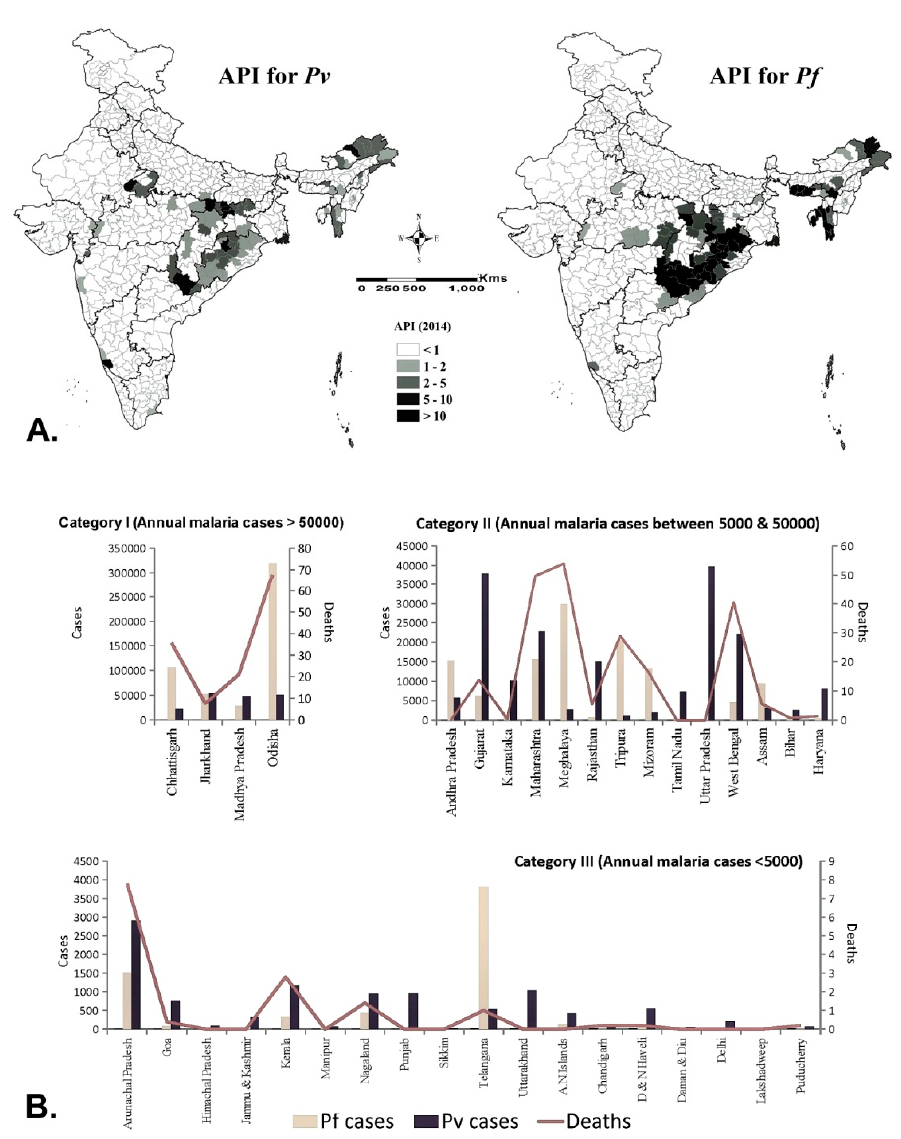
Figure 1. ( A ) Annual parasite incidence (API) for Plasmodium vivax ( Pv ) and Plasmodium falciparum ( Pf ), 2014; ( B ). State wise average annual distribution of Pv , Pf and death cases (2013–2017). (Data source: NVBDCP).